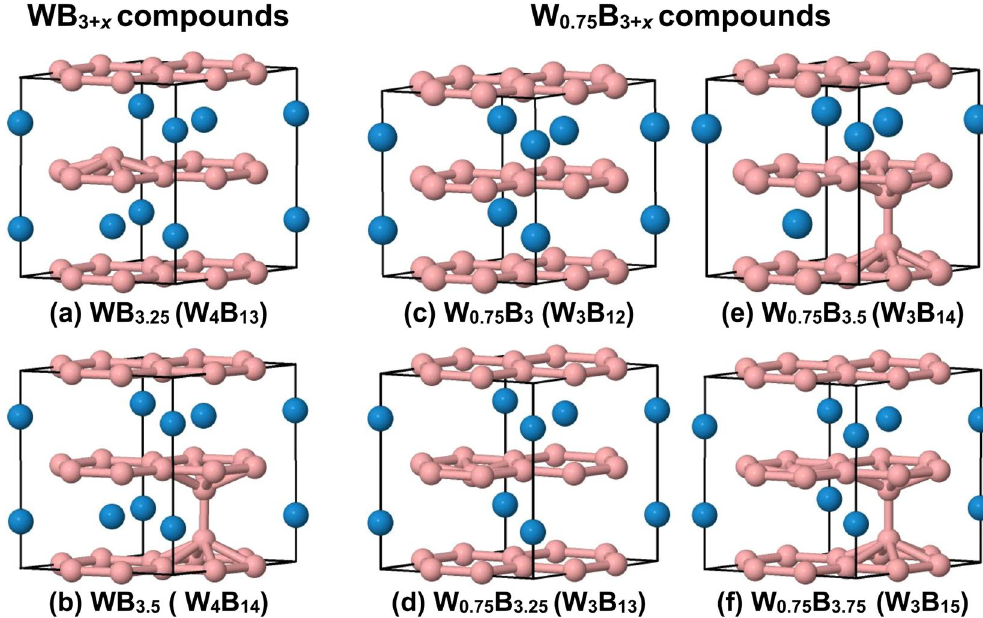
Figure 3. The crystal structure of several boron-rich phases of the W-B system. The large and small spheres represent tungsten and boron atoms, respectively. The W m B n notation in parenthesis shows the number of W and B atoms in the unit cell.